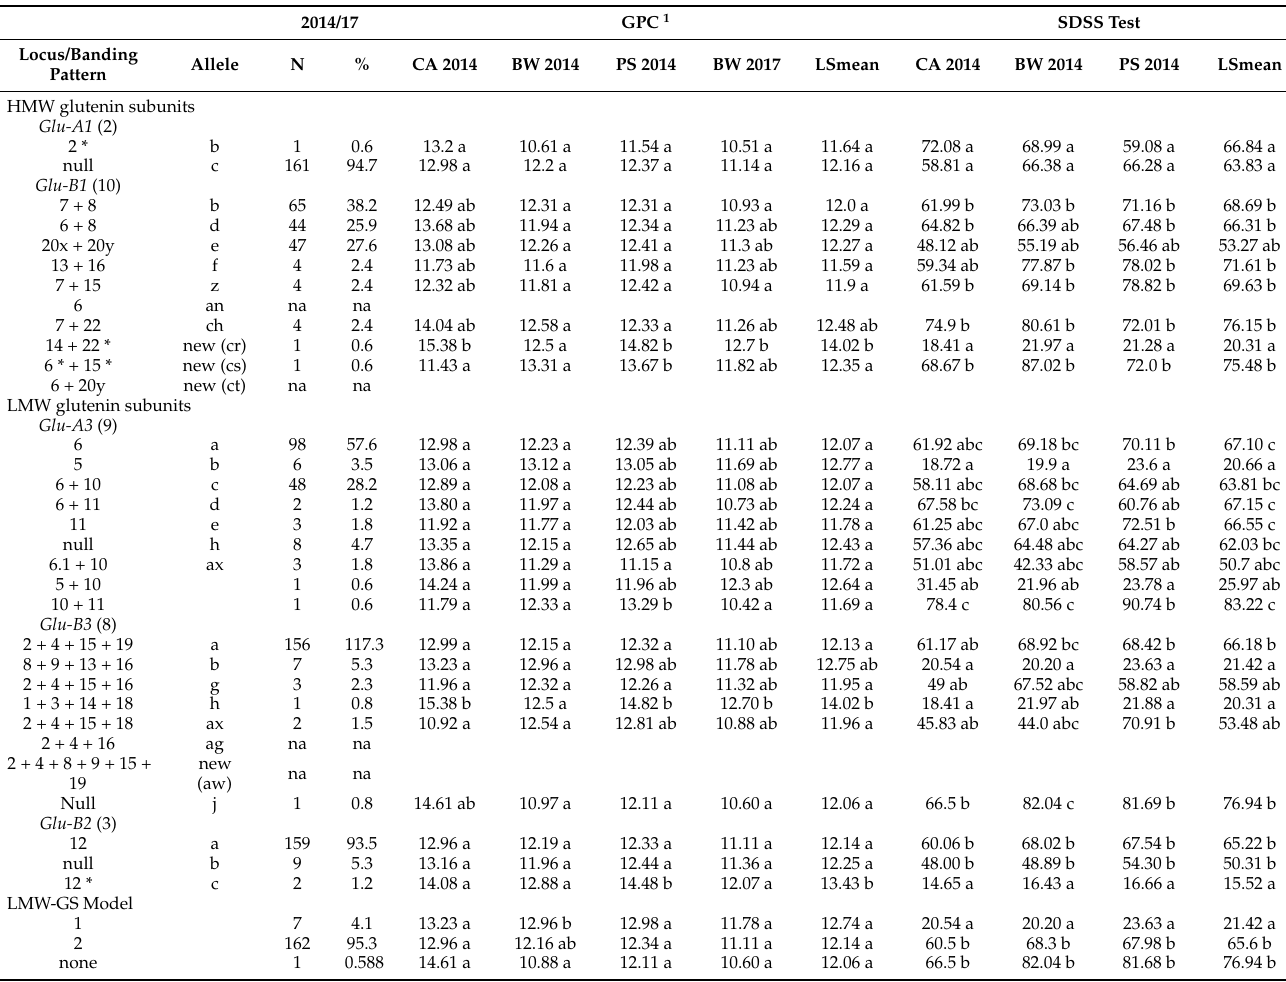
1 LSMEAN estimated using 132 genotypes in each environment and over the environments. GPC: grain protein content; SDSS: sodium dodecyl sulfate micro-sedimentation. The environmental references are CA: Cabildo; BW: Barrow; PS: Pieres, followed by the year of sowing. Values in the same column for each locus followed by a different letter are significantly different using the Tukey–Kramer test ( p < 0.01). * corresponds with bands showing a slightly mobility difference in SDS-PAGE respect to the original band with the same